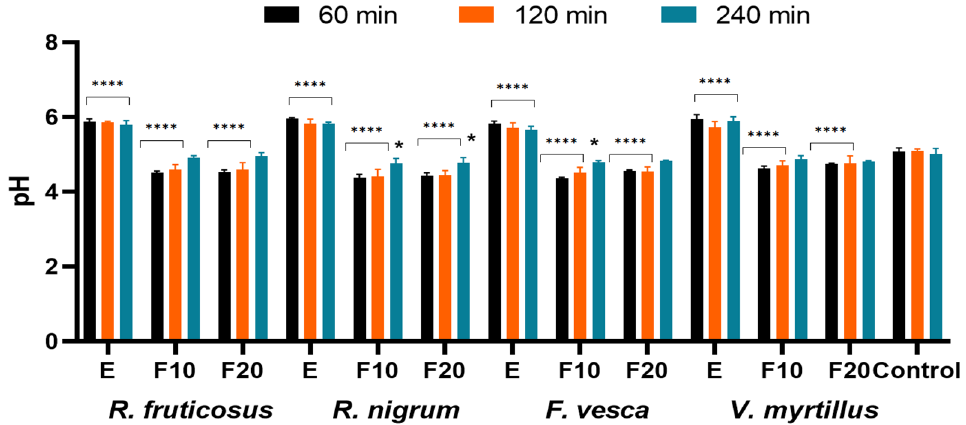
Figure 12. The influence of R. fruticosus L., R. nigrum L., F. vesca L., V. myrtillus L. extract and kombucha ferments (at concentration of 300 µ g/mL) on skin pH. Data are the mean ± SD of five independent measurements. **** p < 0.0001, * p < 0.040. versus the control.